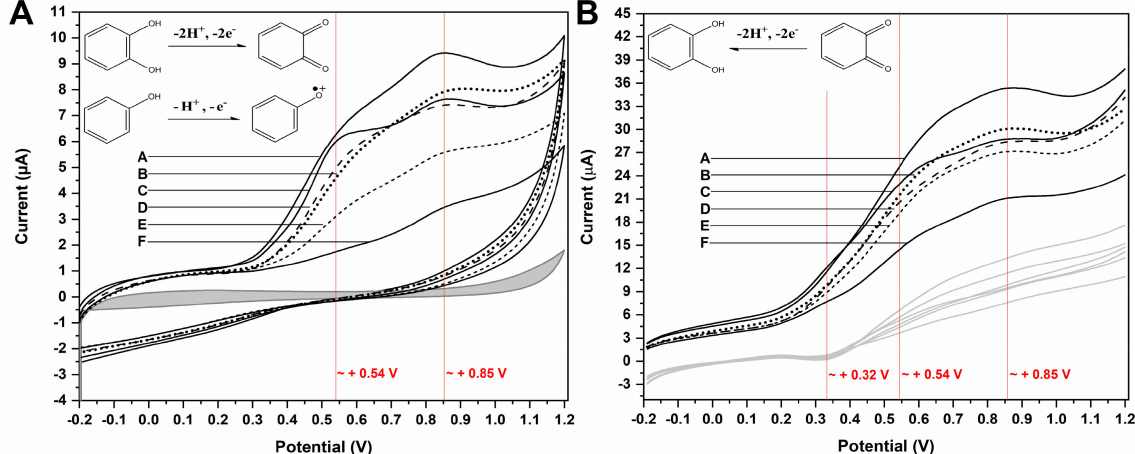
Figure 1. ( A ) CV and ( B ) SWV outputs of each selected red wine sample (A to F). The electric potential associated with the main possible faradaic signals which could be hinted at in the voltammograms is therein highlighted in red. The blank CV signal is represented in gray, and the SWV plot comprises the forward currents of each sample (therein indicated), and the reverse current is in light gray. Moreover, the possible physical origin of the signals is represented by the mechanisms as inset